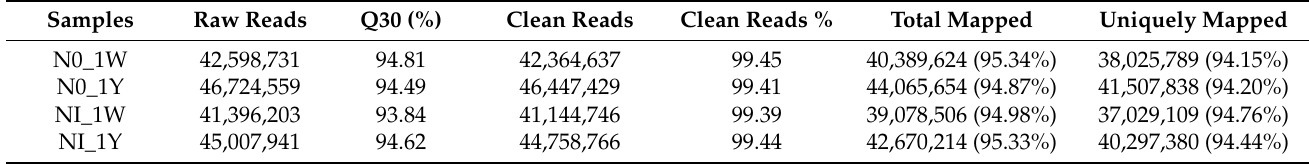
Table 1. RNA sequencing reads and mapped to the wheat